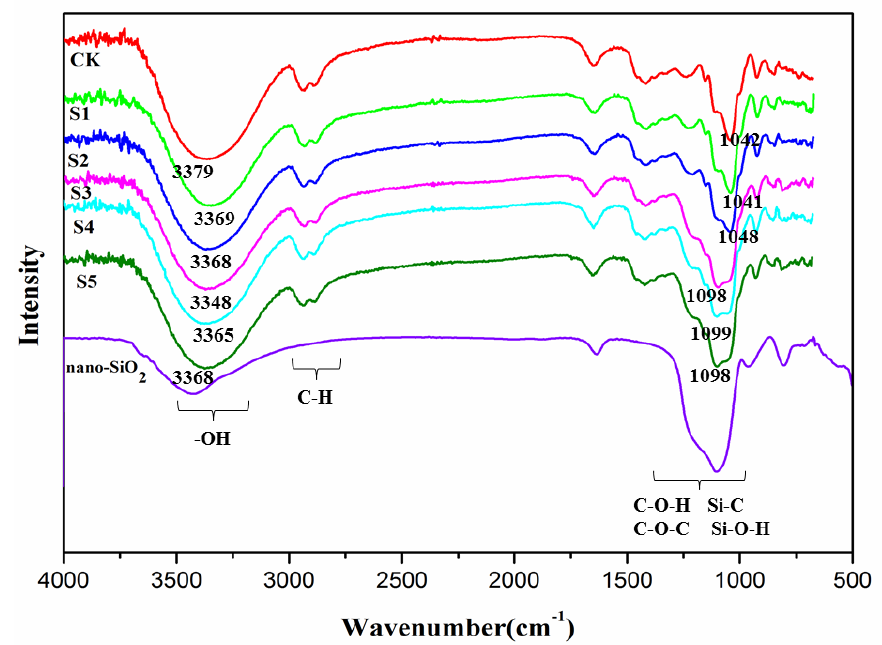
Figure 2. Fourier-transform infrared spectroscopy (FTIR) spectra of blend films (CK: 0% nano-silica; S1: 0.1% nano-silica; S2: 0.2% nano-silica; S3: 0.3% nano-silica; S4: 0.4% nano-silica; S5: 0.5% nano-silica).